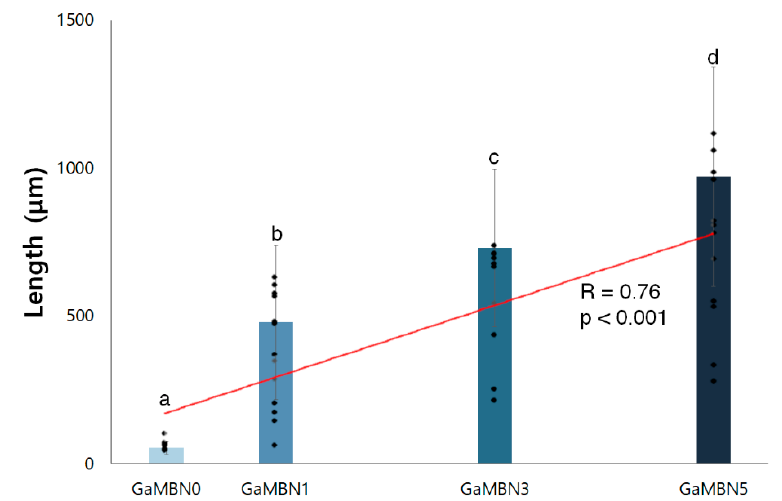
Figure 12. Remineralization length of GaMBN-containing resins, measured using ImageJ. The same alphabet letter indicates no statistically significant difference between the groups (p < 0.05) by Duncan’s multiple comparison test. Error bars represent the standard deviation (n = 10).